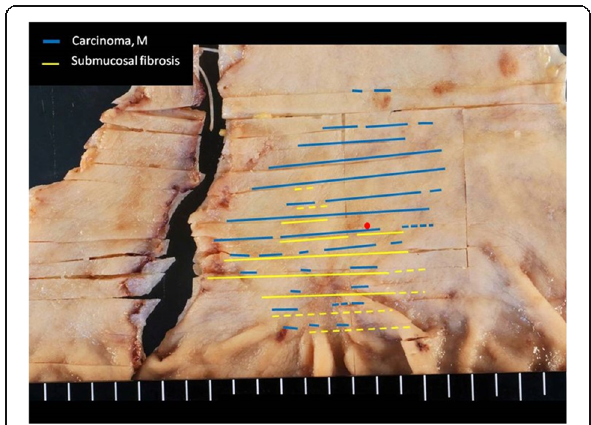
Fig. 2 Tumor mapping of the resected specimen. The carcinoma and fibrosis overlapped partially. Lymphatic invasion below the muscularis mucosa was identified at the position of the red dot